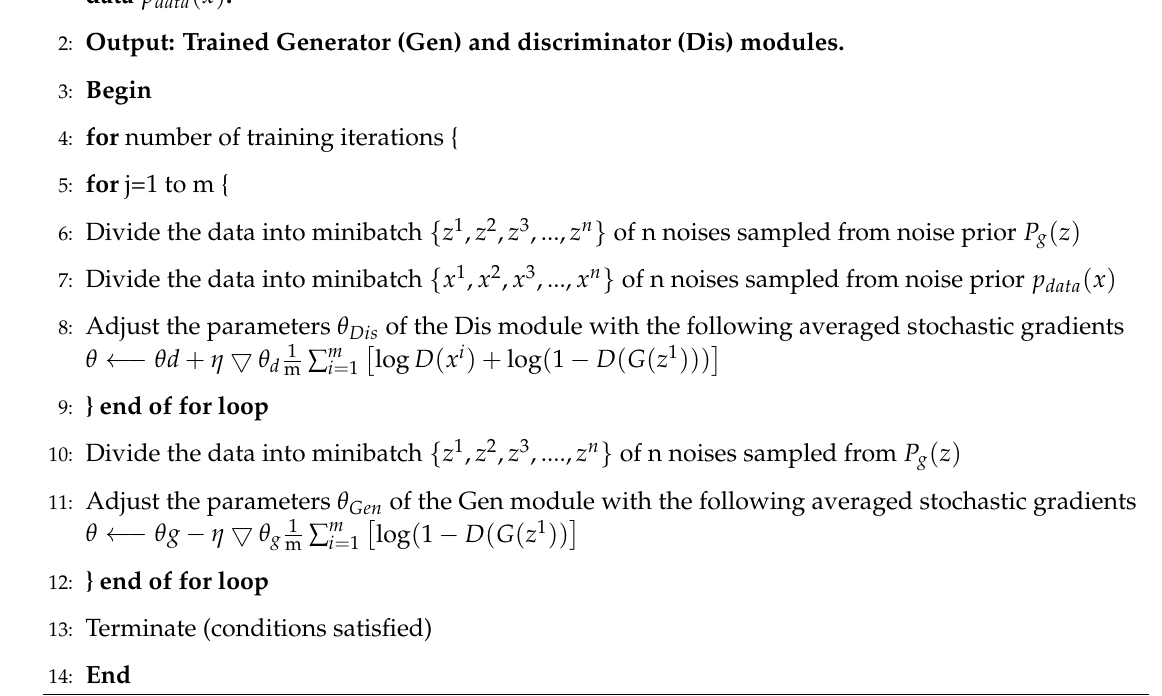
Algorithm 1 Pseudo-code for the generative adversarial network (GAN)